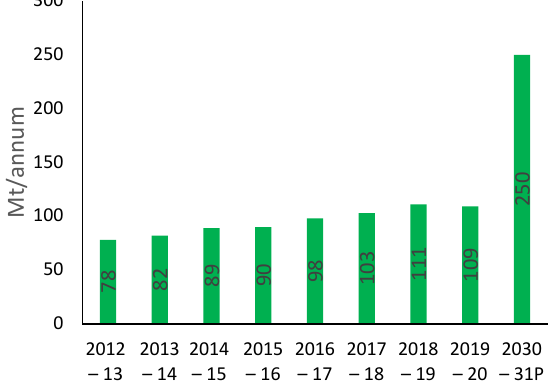
Figure 1. Crude steel production; (Graph plotted using data from ministry of steel [3]).